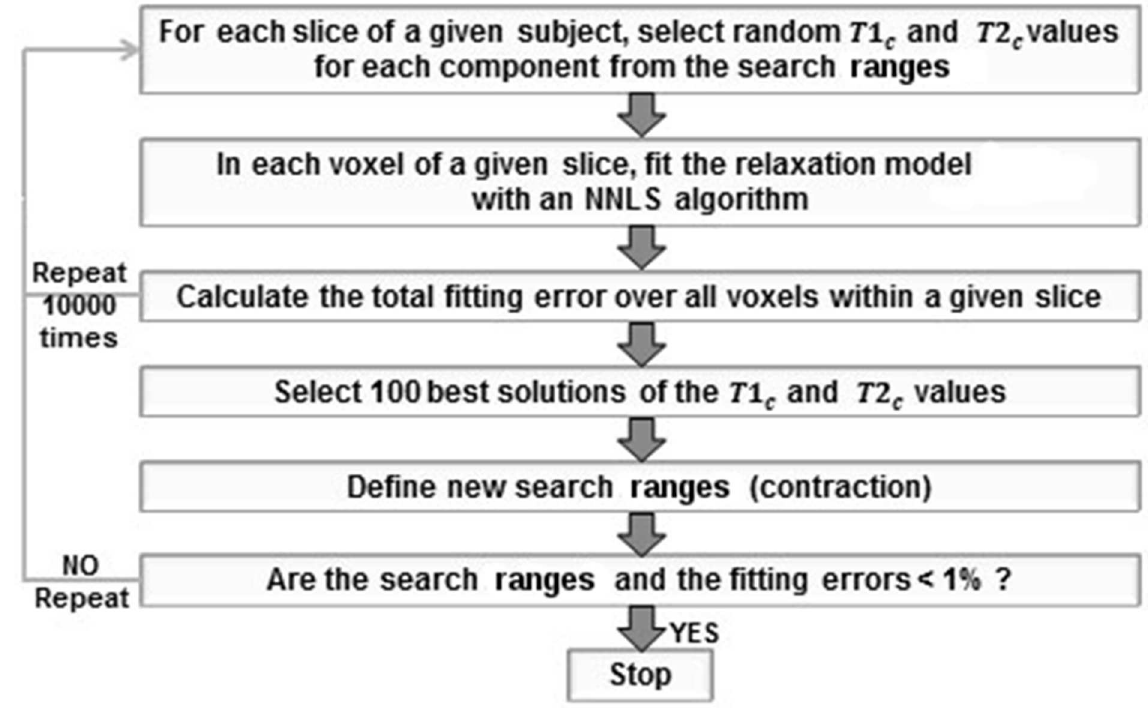
Fig 1. Schematic representation of the fitting algorithm. The fitting procedure was performed either for each voxel (voxel-wise approach) or for each slice (calibration approach) independently. The fitting steps were repeated until both the fitting error and the differences between the upper and lower borders of the search ranges became less than